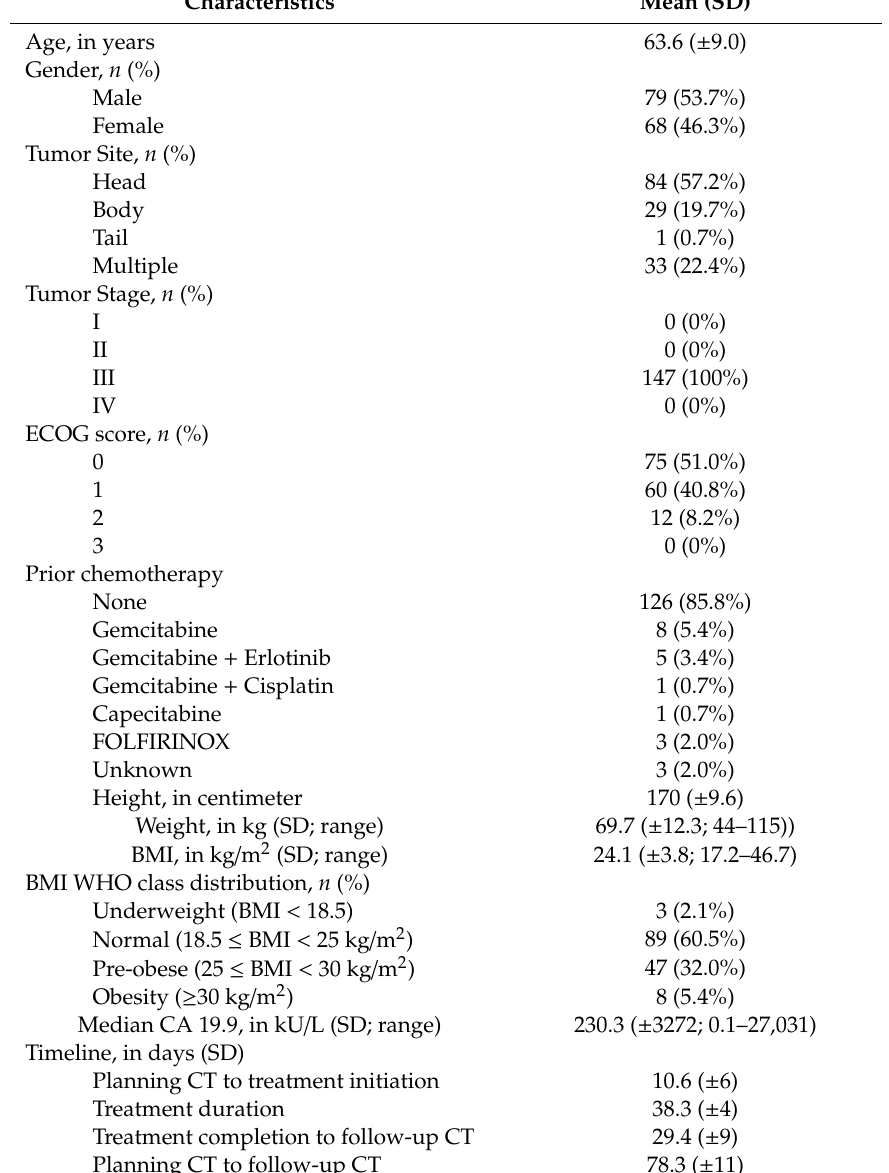
Table 1. Demographics, baseline parameters and treatment